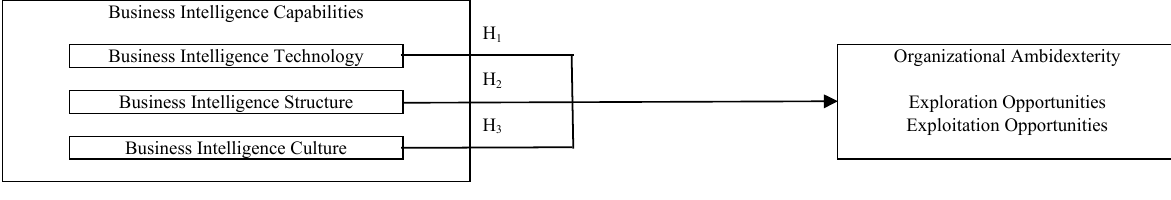
Fig. 1. The proposed